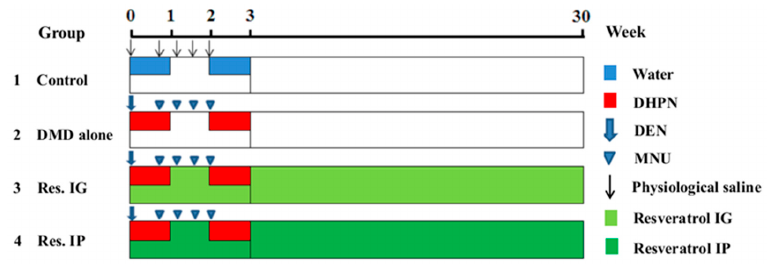
Figure 1. Experiment protocol for DMD-induced rat carcinogenic model. Rats in G2–G4 were sequentially treated with DEN (100 mg/kg body weight, IP, single dose), MNU (20 mg/kg body weight, IP, four times, on days 5, 8, 11, 14) and DHPN (0.1% in the drinking water, during weeks 1 and 3). Rats in G3 received resveratrol (20 mg/kg by body weight) via intragastric route (IG) in two day intervals for 30 weeks. Rats in G4 received resveratrol (20 mg/kg body weight) via intraperitoneal route (IP) in two day intervals for 30 weeks. The rats in G1 were given vehicle